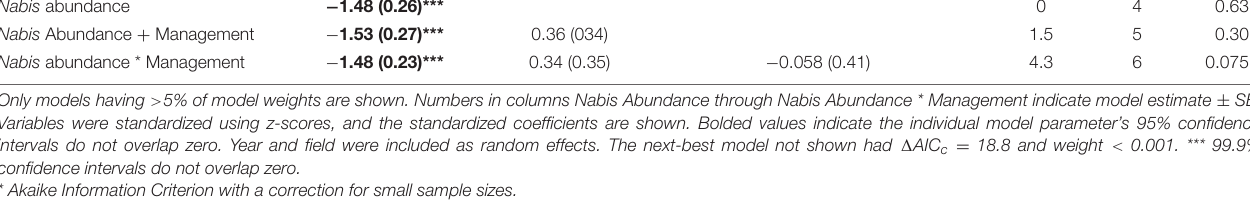
TABLE 2 | Model selection results for arthropod community and farm management (conventional = 0, organic = 1) that influence the probability of detecting thrips DNA in Nabis guts.